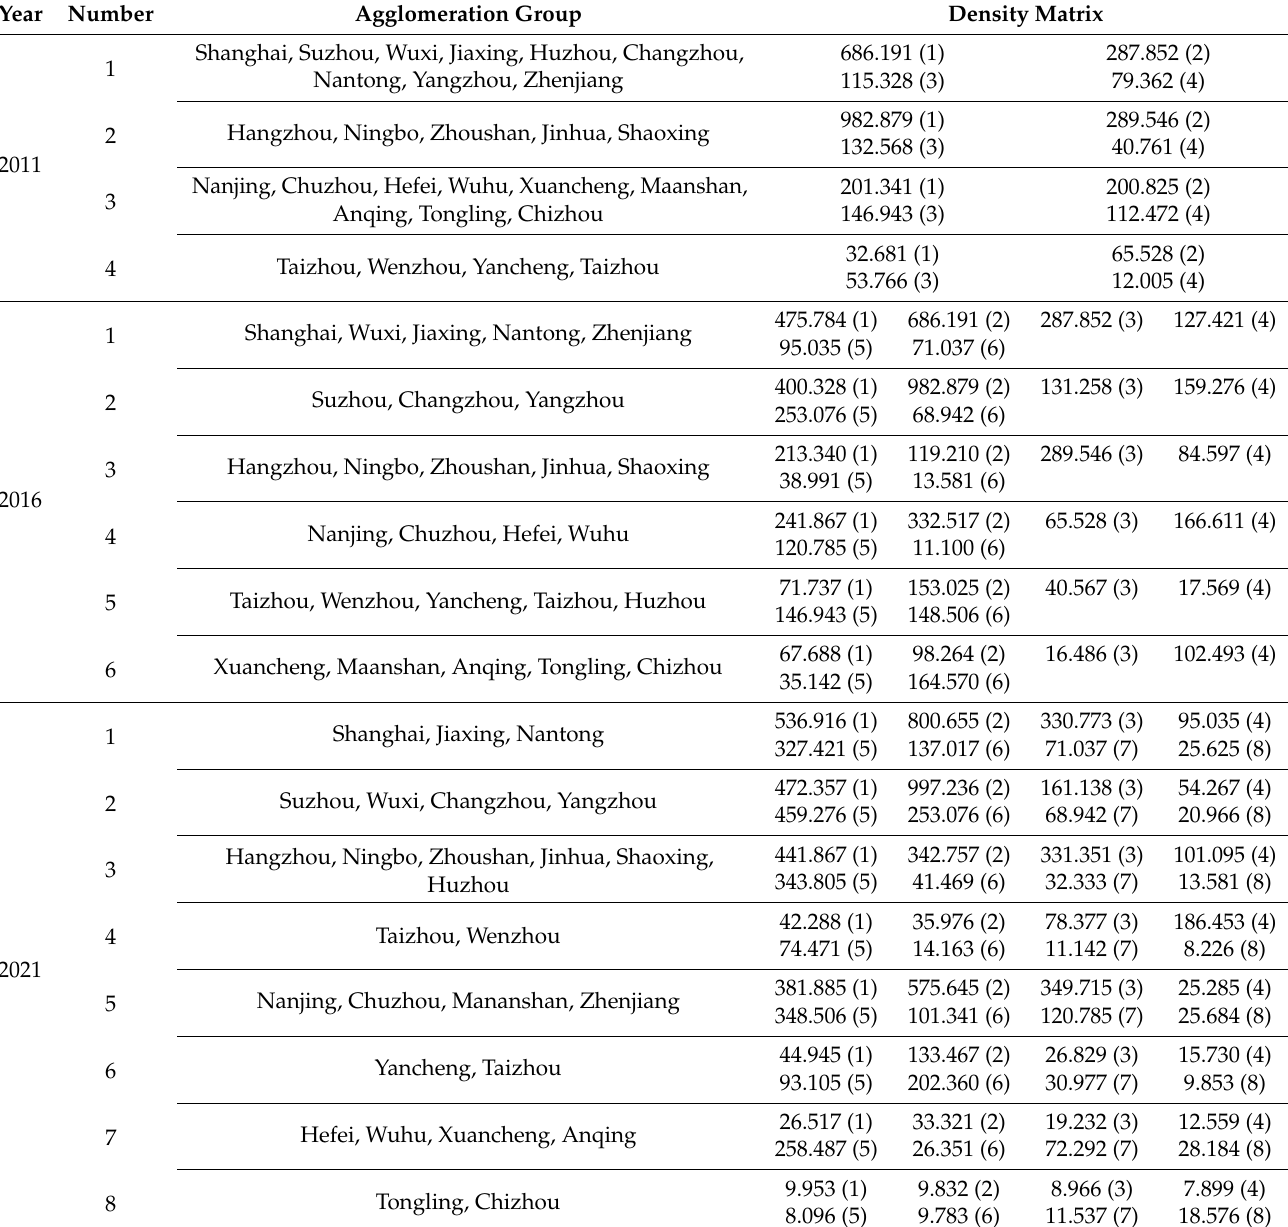
Table 2. Agglomeration groups of the economic relations network of Yangtze River Delta city